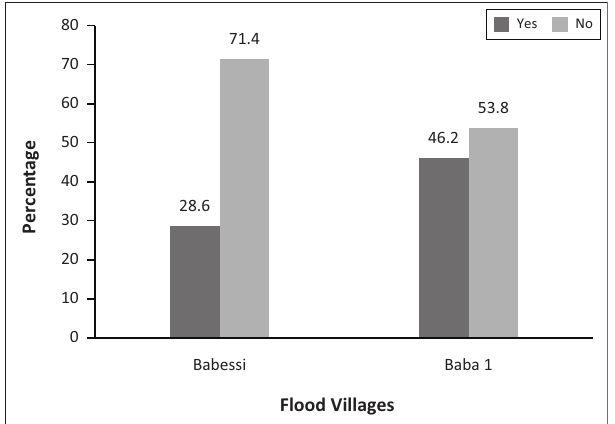
FIGURE 3: Households with leadership positions in groups or